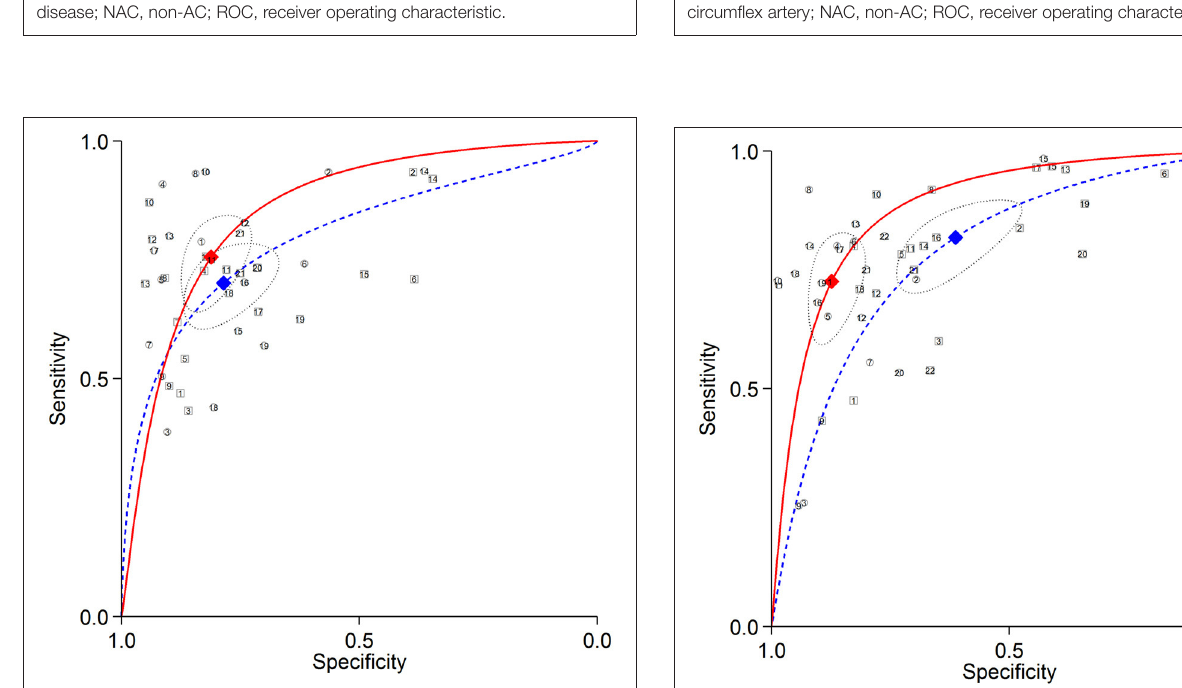
FIGURE 2 | Summary ROC curves of diagnosing CAD at a patient level. Comparisons of summary ROC curves between all AC (solid line) vs. all NAC (dashed line). Each circle (AC) and square (NAC) represent an individual included study. Diamonds represent summary operating points of pooled sensitivity and specificity. AC, attenuation correction; CAD, coronary artery disease; NAC, non-AC; ROC, receiver operating characteristic.